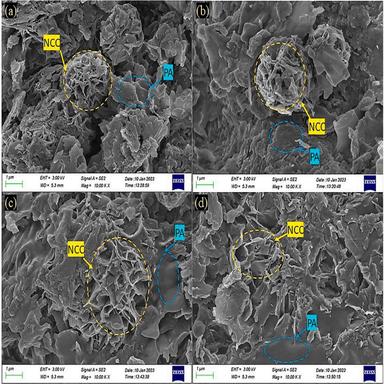
SEM images of PA-NCC with different PA contents (a) 65 % PA-NCC; (b) 70 % PA-NCC; (c) 75 % PA-NCC; (d) 80 % PA-NCC.